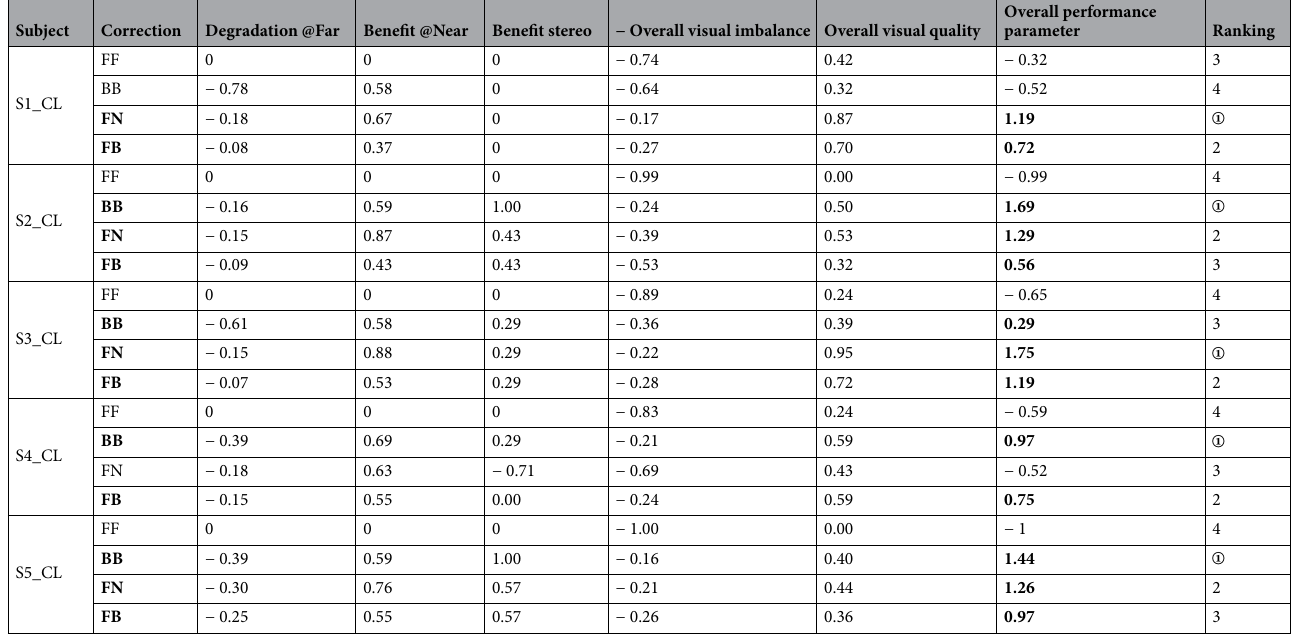
Table 3. Individual data of visual degradation at far distance, visual benefit at near distance, near stereo benefit, overall visual imbalance (negative), overall visual quality, overall performance parameter and ranking. Corrections in bold indicate acceptable overall performance. Circled correction ① indicates the highest ranking. Data correspond to measurements performed with